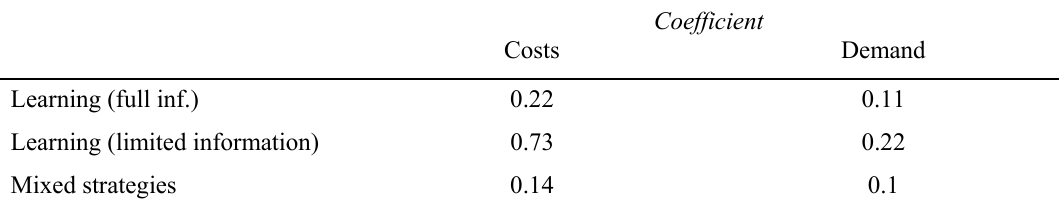
Table 6. Rejection rates for GMM regressions’ coefficients